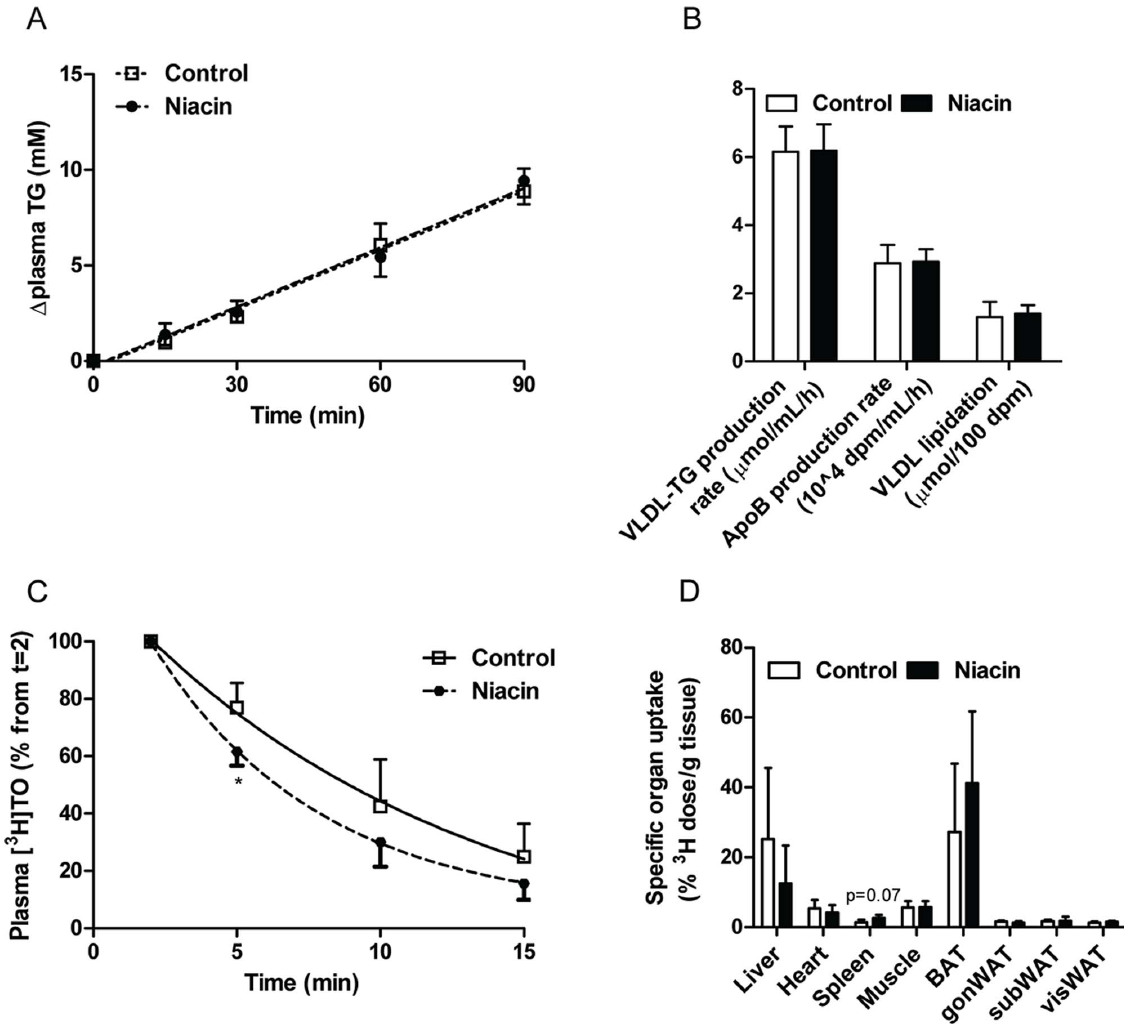
Figure 2. Effect of niacin on VLDL production and clearance. To determine VLDL production, mice were injected with Trans 35 S label and tyloxapol and the accumulation of TG in plasma (A) and the production rate of VLDL-TG and apoB, as well as VLDL lipidation, defined as the ratio of VLDL-TG/apoB, were determined (B). To determine VLDL clearance, mice were injected with glycerol tri[ 3 H]oleate- and [ 14 C]cholesteryl oleate-labeled VLDL-like emulsion particles. Plasma 3 H-activity was determined as percentage of the initial dose (C), and uptake of 3 H-activity by various organs was determined as percentage of the injected dose per gram wet tissue (D). (BAT, brown adipose tissue; gonWAT, gonadal white adipose tissue; subWAT, subcutaneous white adipose tissue; visWAT, visceral white adipose tissue; values are means 6 SD; n=6 per group for VLDL production and n=3–5 per group for VLDL clearance; *P , 0.05 as compared to control).